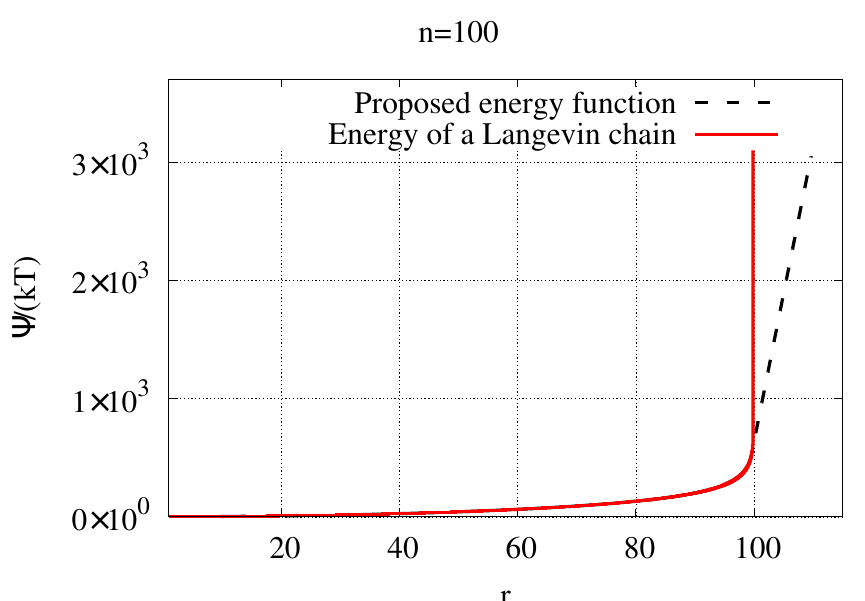
Figure 6. Comparison of ψ P against the energy of a Langevin chain. (Note that k − 1 T − 1 ≈ N P is assumed.)